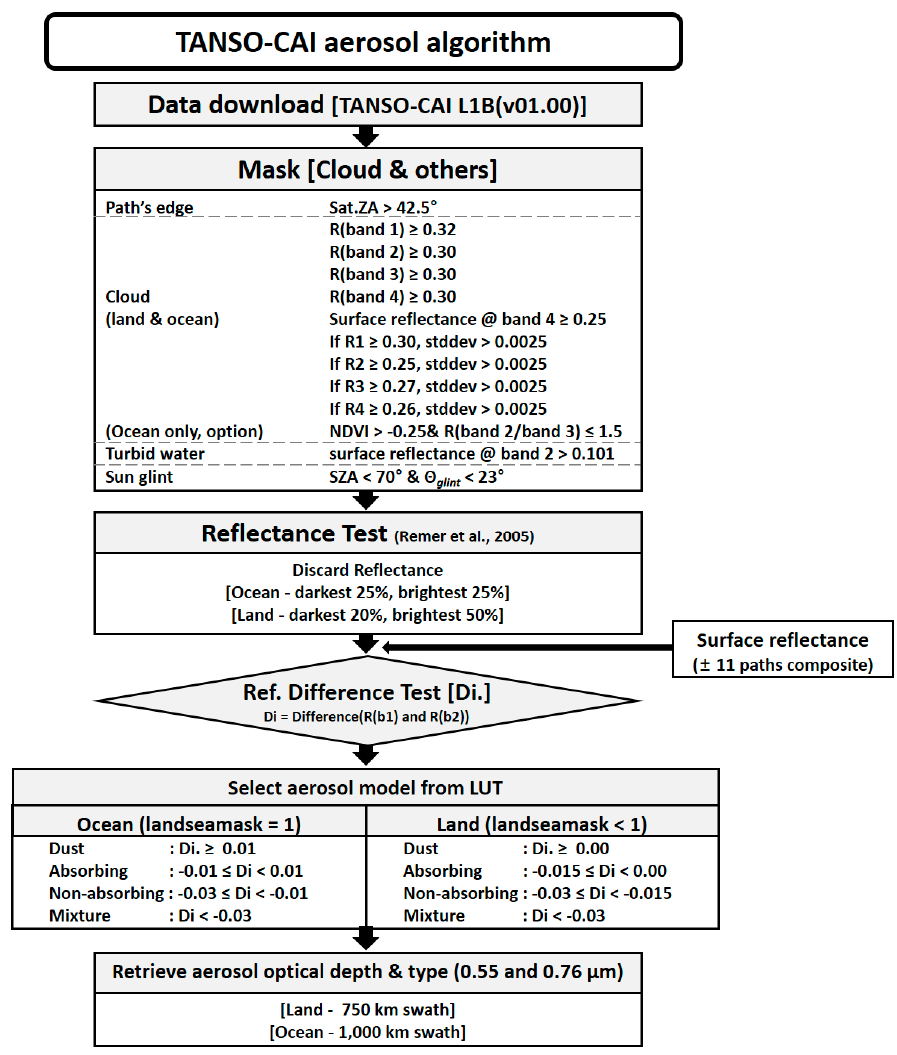
Figure 4. The flowchart of the TANSO-CAI aerosol retrieval algorithm.